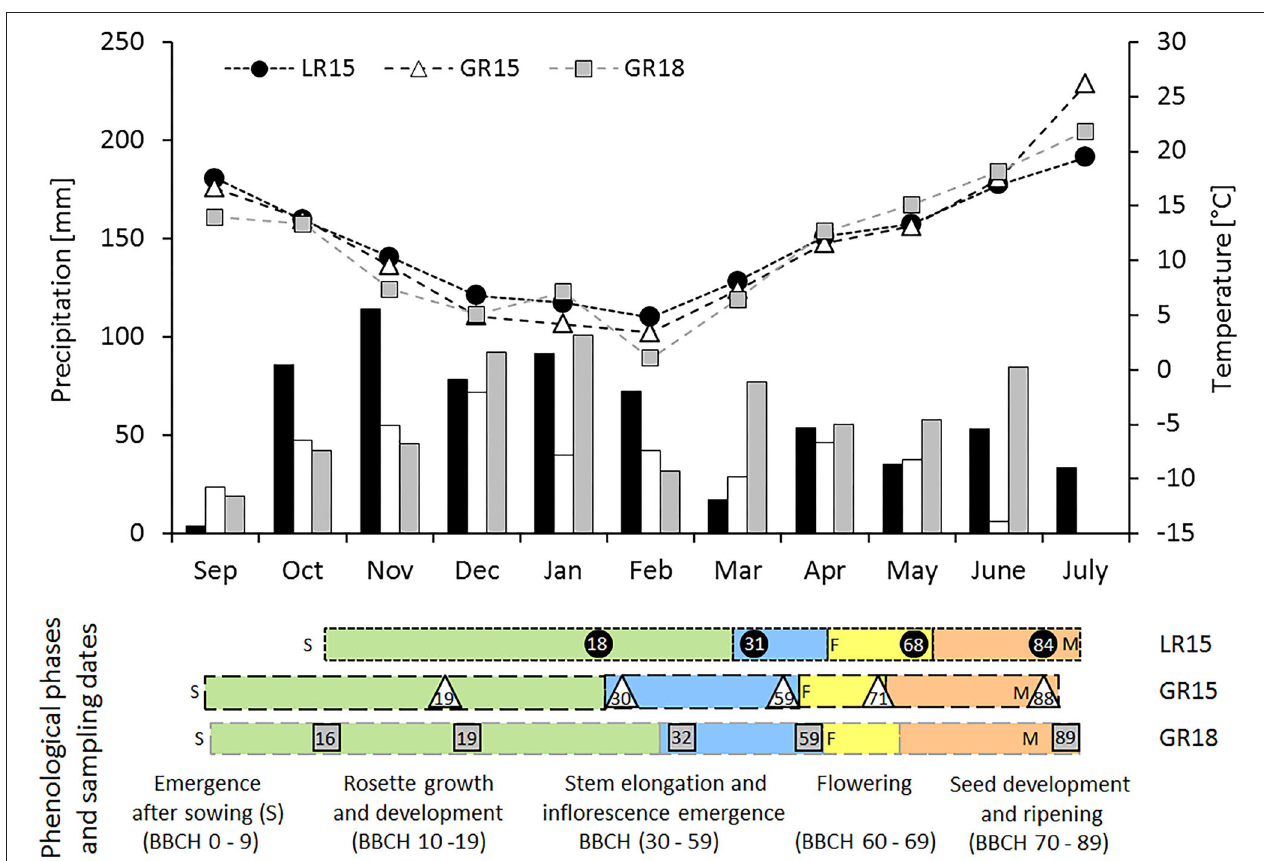
FIGURE 1 | Total monthly precipitation (bars), mean monthly temperature (lines) and sampling dates and phenology of the AVISO genotype in the three experiments. Grayscale bars and symbols correspond to the three experimental sites × climate years (black circles, LR15; white triangles, GR15; gray squares, GR18). In the down panel, colors correspond to the four main phenological phases (green, rosette emergence, growth, and development; blue, stem elongation, and inflorescence emergence; yellow, flowering; orange, seed development, and ripening), sampling dates are indicated by symbols, whereas numbers depict phenological stages according to the BBCH scale ( Lancashire et al., 1991). Letters correspond to experimental management (S, sowing) or phenological markers (F, beginning of flowering; M, seed maturity).